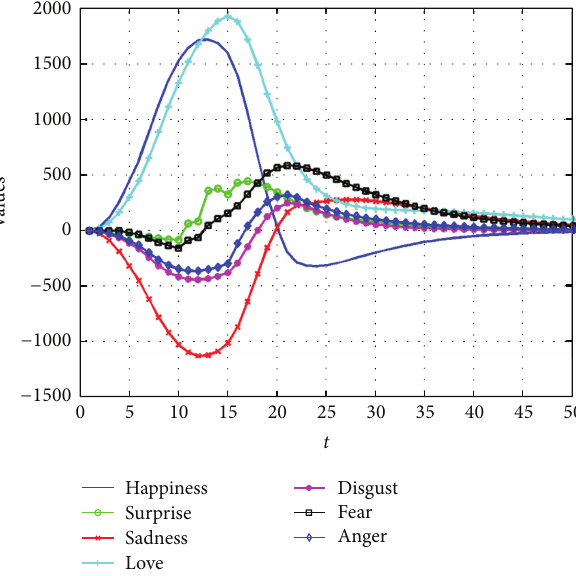
Figure 4: Graph of emotions generated by senior males.